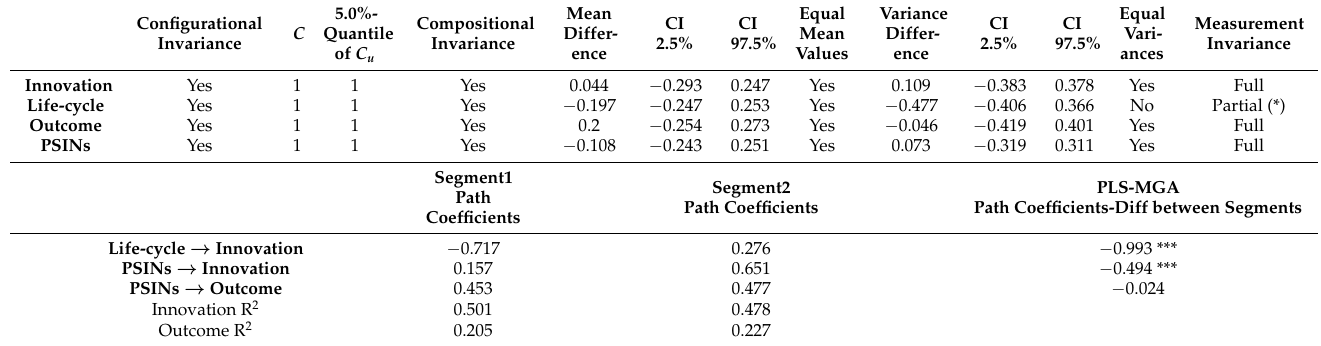
Table A6. Results of the PLS-POS analysis, including the measurement invariance and multigroup analysis (PLS-MGA). Configurational Invariance